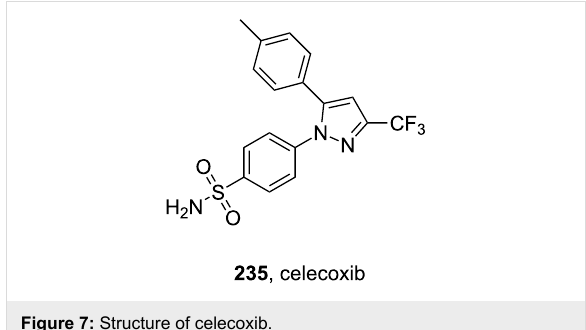
Figure 7: Structure of